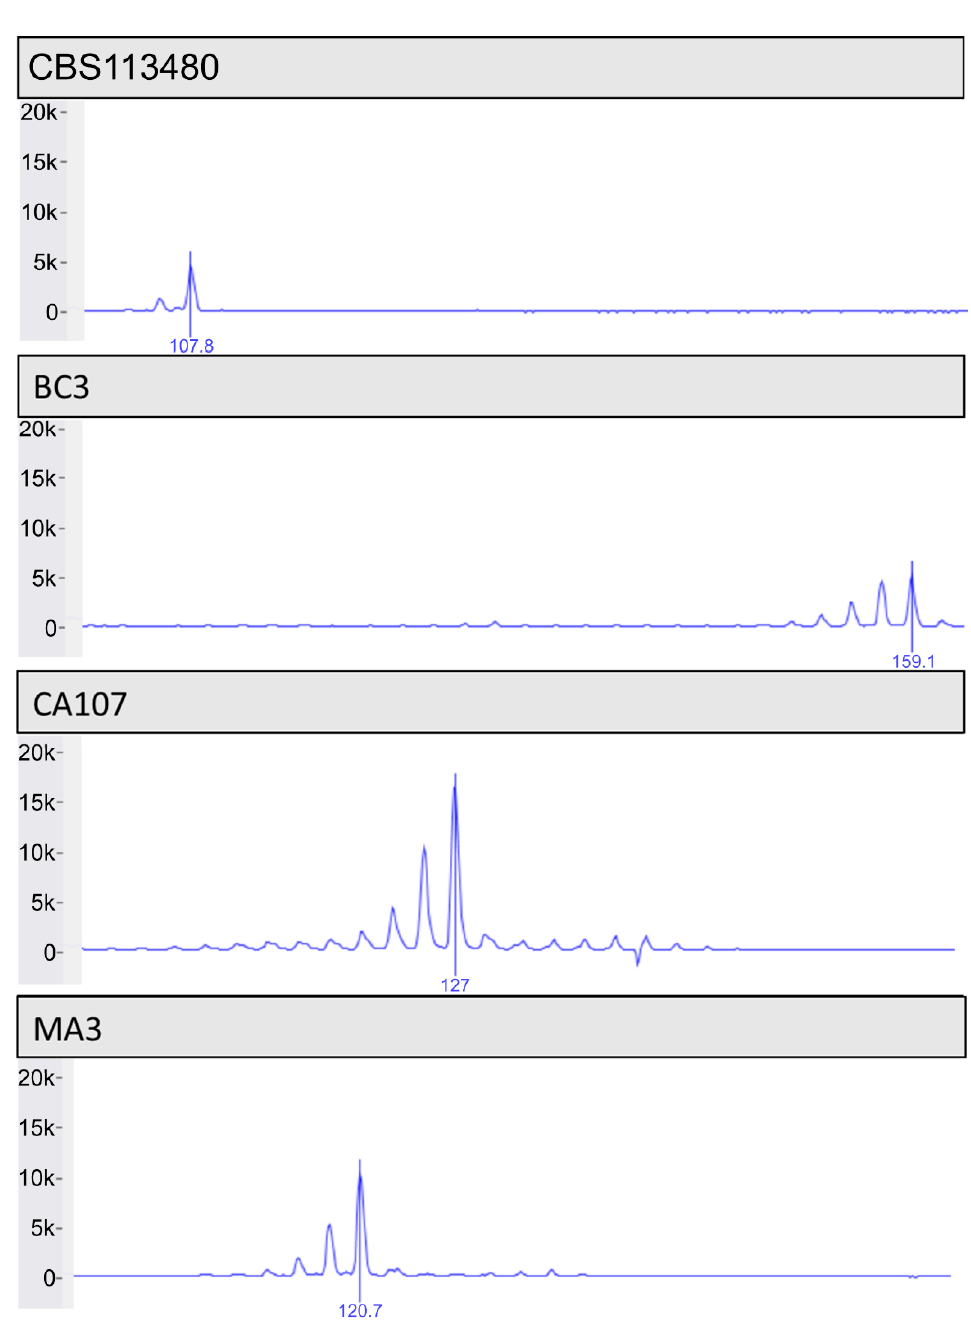
Figure 1. Representative images of microsatellite genotypes. MS4 peaks of unrelated isolates (CBS 113480, BC3, CA107, MA3) showing varying allele sizes at 107 bp, 159 bp, 127 bp, and 121 bp, respectively. CBS = Westerdijk Fungal Biodiversity Centre; BC = Boulder County, CO; CA = California; MA = Massachusetts.